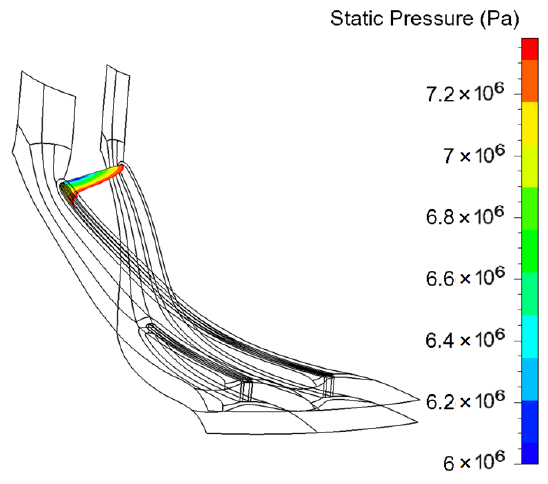
Figure 12. The cross critical region of the blade surface.